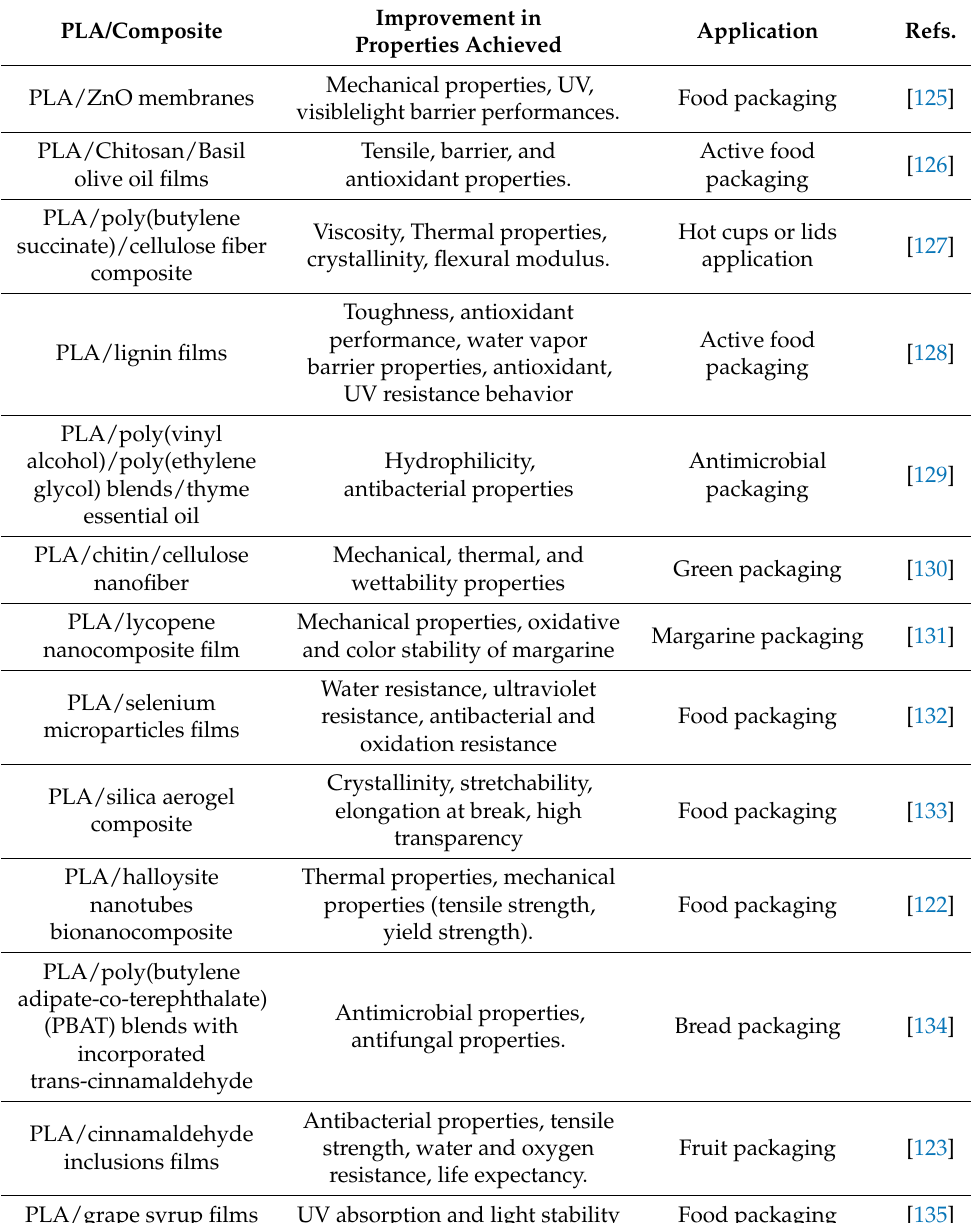
Table 2. Improvement in properties achieved and applications of PLA